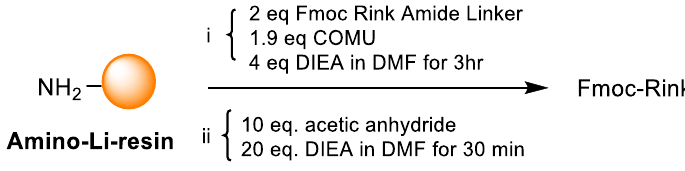
Figure 4. SEM images of crude amino-Li-resins: ( i ) 200 µm; ( ii ) 100 µm; ( iii ) 20 µm; and ( iv ) 10 µm. Fmoc Rink-Amide linker was incorporated into the amino-Li-resin by reacting the swelled resin with 4 eq. of Fmoc Rink-Amide linker (431.7 mg, 0.8 mmol), 3.8 eq. COMU (325.5 mg, 0.76 mmol), a slightly lower amount of COMU was used to prevent the capping of the amino function with the formation of the corresponding guanidino derivative [31] and 8 eq. DIEA (278.2 µ L, 1.6 mmol) in DMF (3 mL) for 3 h (Scheme 1, Figure 4). The Fmoc Rink-Amide-Li-resin was then filtered by gravity, washed with DMF (5 mL × 3), filtered again by gravity, and then capped with the addition of 10 eq. acetic anhydride (Ac 2 O) (377.8 µ L, 2 mmol) and 20 eq. of DIEA (1390.8 µ L. 4 mmol) in DMF (3 mL) for 30 min. The solvent was then drained by gravity filtration and the resin was washed with DMF (5 mL × 3). Similar to what was established in Section 2.3.1 above, the loading of the Fmoc Rink-Amide linker onto the amino-Li-resin was assessed in triplicates and averaged to be 0.4 mmol/g.